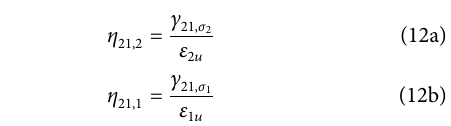
Table 1. The panels were divided into fi ve sets, with each set consisting of four panels. Out of the four, the values of tension applied in two panels corresponded to pre-yield and those in the other two corresponded to post-yield condition of the bars. To check repeatability, two panels were tested under a certain